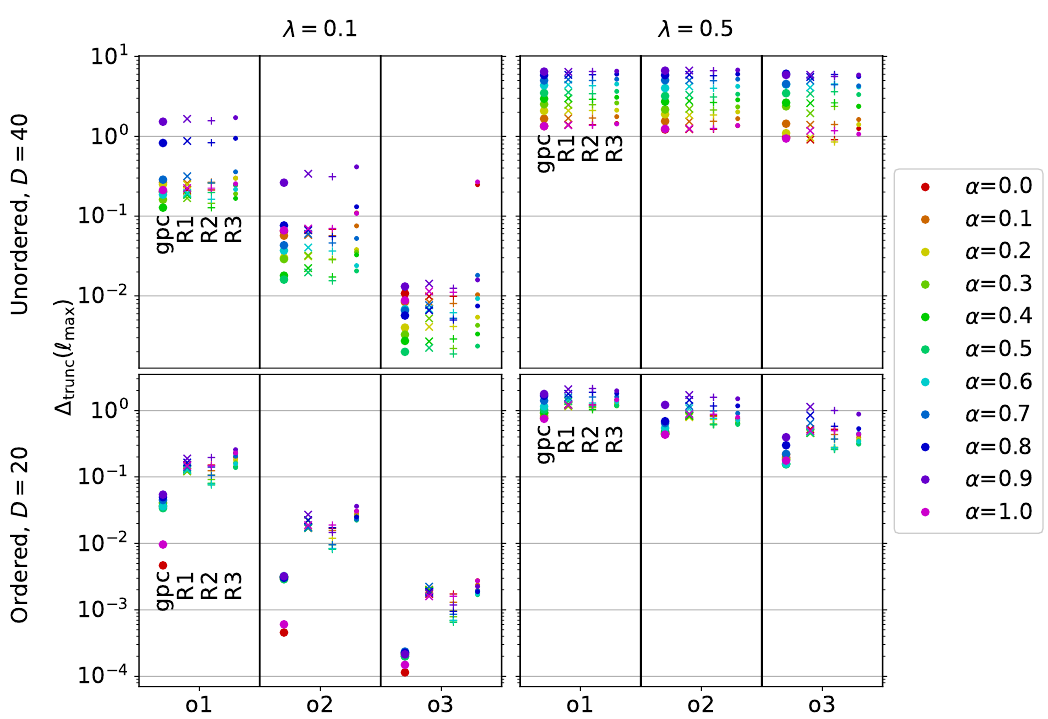
( ℓ ) between exact spectrum of the truncated Figure 5: Truncation error ∆ trunc max ordered matrix and the flow equation result of the matrices described in Sec. 4.3.3, averaged over 100 samples each. The top row shows results for random matrices M , the bottom row shows results for ordered matrices. The truncation order is denoted by (o1,o2,o3) for truncation in order (1,2,3). crossover ratio α is the same parameter we used for sampling the random matrix in